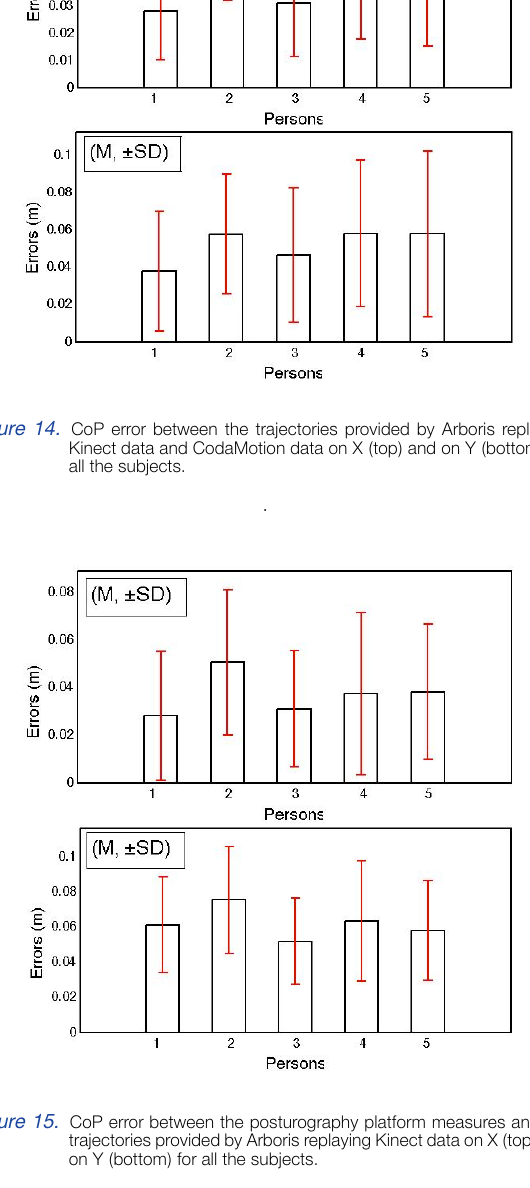
3. Subject walked in his CWS wearing a ski boot on the right